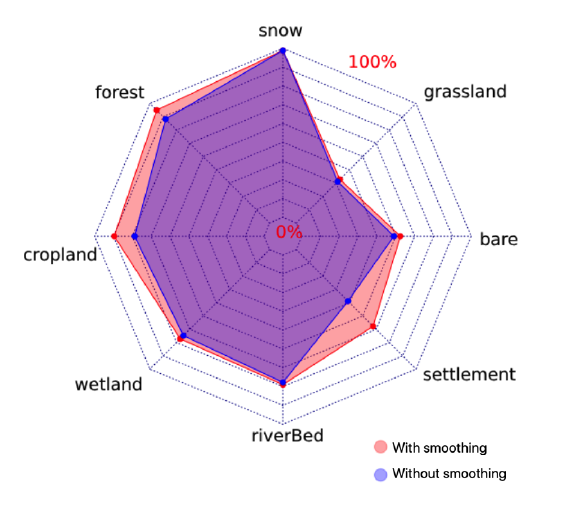
Figure 6. Comparison of class wise accuracy before applying any smoothing and after selecting the best primitives from various smoothing results. In the plot, accuracy extends from 0% (at centre) to 100% (at the outer